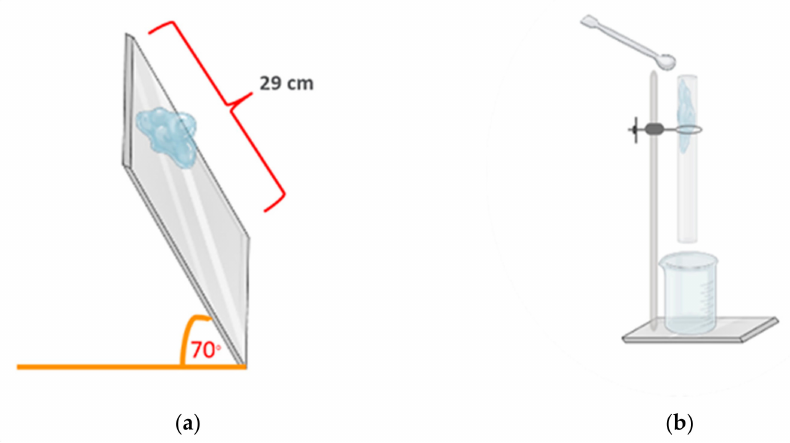
Figure 11. Schematic of ( a ) the tilted-aluminum-plate test and ( b ) the tablet-through-a-tube test. Tablet Carrying through a